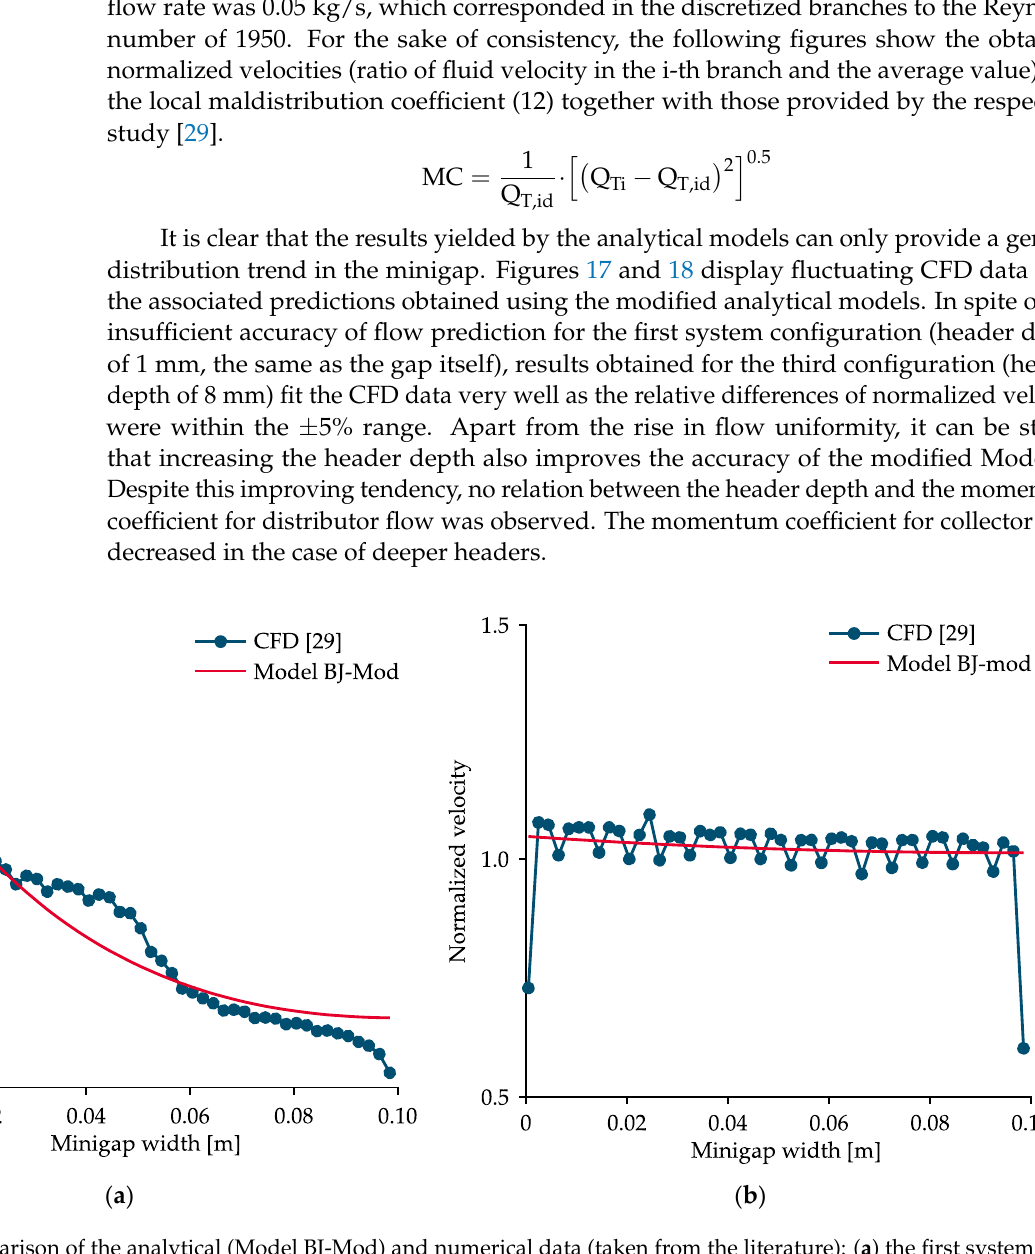
Figure 18. Comparison of the analytical (Model BJ-Mod) and numerical data (taken from the liter- ature) for the second system configuration (header depth of 2 mm), momentum coefficients for flow in the distributor—0.65, collector—3.10. 4.2. Industrial Steam Superheater As for conventional heat transfer equipment, such as sectional tubular heat exchang- ers in boilers or steam generators, some maldistribution is always present but usually it is too low to concern the operators. However, this is only true if the equipment is designed properly and operates under stable conditions, as any process fluid flow instability may induce serious problems. It will be demonstrated here that even a minor flow non-uni- formity can cause operating problems in an industrial steam superheater. The respective steam superheater was introduced by previous studies [39,40,54]; therefore, only brief in- formation follows: